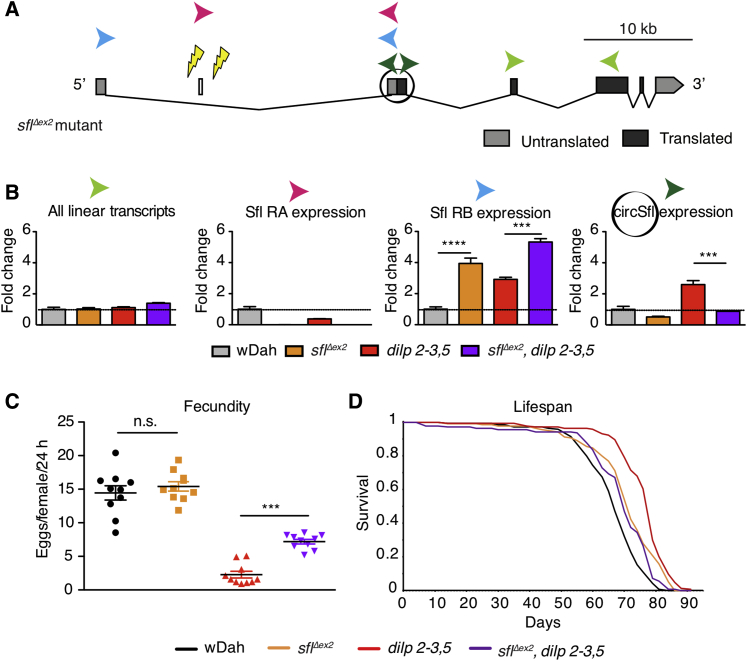
Backsplicing of the sfl circRNA Depends on the Presence of an Upstream Non-coding Exon, which Is Essential for IIS-Mediated Lifespan Extension(A) Scheme of the mutated sflΔex2 gene locus. The sequence deleted by CRISPR-Cas9 in sflΔex2 mutant flies is indicated by yellow flashes. The primers used for qRT-PCR in (B) of the different sfl transcripts are indicated by arrowheads. The exon forming circSfl is indicated by a circle.(B) Total linear Sfl RNA levels were not affected by removal of sfl exon 2. As expected, Sfl RA transcripts were absent in flies containing the sflΔex2 deletion, and Sfl RB transcript levels were significantly upregulated in these flies. Importantly, circSfl expression was decreased in sflΔex2 mutant flies, and the increased expression of circSfl in dilp 2-3,5 mutants was reversed to wild-type levels in sflΔex2, dilp 2-3,5 double-mutant flies (∗∗∗p < 0.001, ∗∗∗∗p < 0.0001, 2-way-ANOVA with Bonferroni post hoc test, n = 3, mean ± SEM).(C and D) A block in circSfl upregulation upon deletion of sfl exon 2 rescued the reduced fecundity (C) and increased lifespan (D) of insulin mutant flies.(C) sflΔex2 mutants showed wild-type fecundity. The low fecundity of dilp 2-3,5 mutants was partially rescued in sflΔex2, dilp2-3,5 double mutants (∗∗∗p < 0.001; interaction, ∗∗p < 0.01; 2-way-ANOVA, Bonferroni post hoc test, n = 10, mean ± SEM).(D) Lifespan extension of dilp 2-3,5 mutants was reduced in flies carrying the sflΔex2 allele (wDah versus dilp 2-3,5: p < 0.0001, sflΔex2 versus dilp 2-3,5: p < 0.0001 log rank test; interaction between sflΔex2 and dilp2-3,5: p < 0.0001, Cox proportional hazard analysis). The sflΔex2 lifespan of sflΔex2 single mutants was not reduced.See also Figure S5.